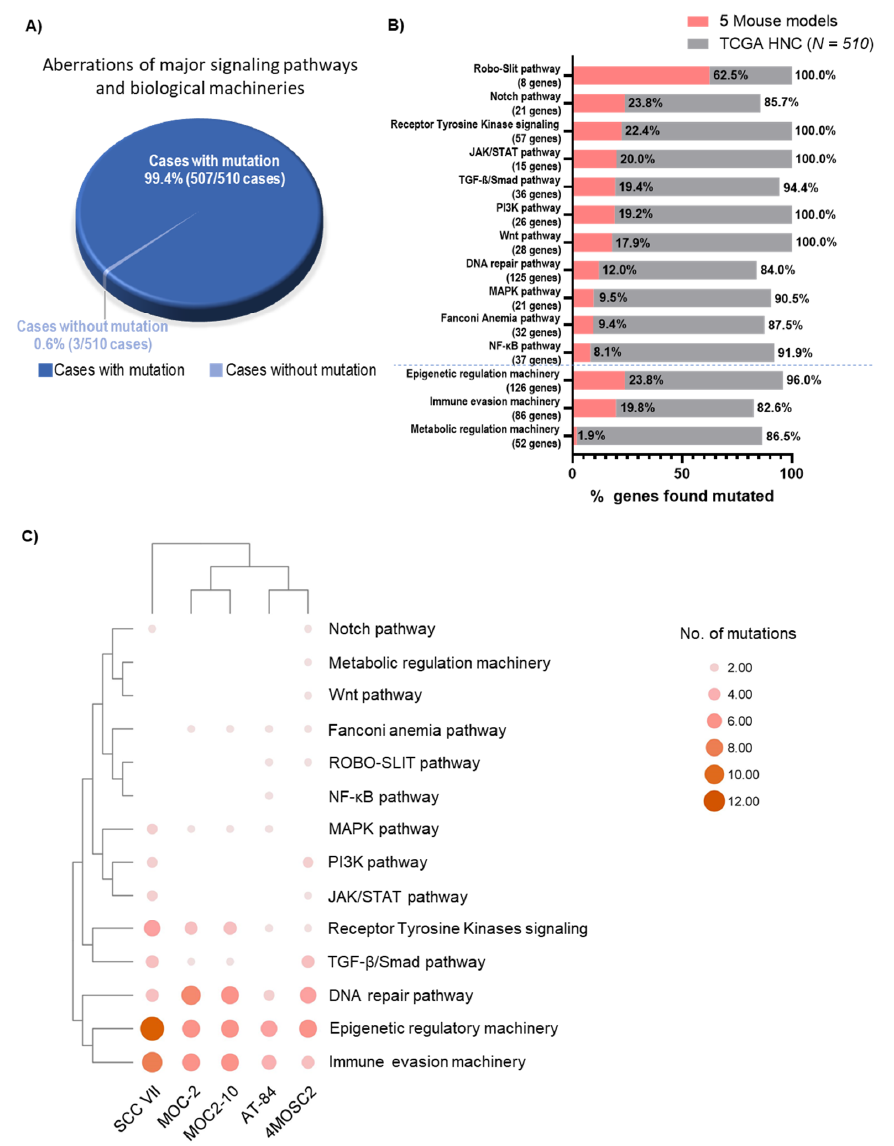
Figure 3. Mouse models with HNC-relevant genetic aberrations of major signaling pathways and biological machineries. ( A ) Pie chart showing percentages of patient tumors harboring mutations of 14 pathways and machineries (Pathways: PI3K, MAPK, JAK / STAT, Notch, Wnt, NF- κ B, TGF- β / Smad, ROBO–SLIT, Fanconi anemia, receptor tyrosine kinases; Machineries: DNA repair, immune evasion, metabolic regulation, epigenetic regulation) in TCGA-HNC ( N = 510) with the 3D sector representing mutations of the same genes found in 5 mouse models. ( B ) Bar graph showing the number of pathway / machinery genes mutated in TCGA-HNC ( N = 510) (grey bars) and the 5 mouse models (red bars). ( C ) Bubble plot showing the abundance of TCGA-HNC ( N = 510) as well as 14 pathways and machineries’ mutations across 5 mouse models (AT-84, SCCVII, MOC-2, MOC2-10, and 4MOSC2).